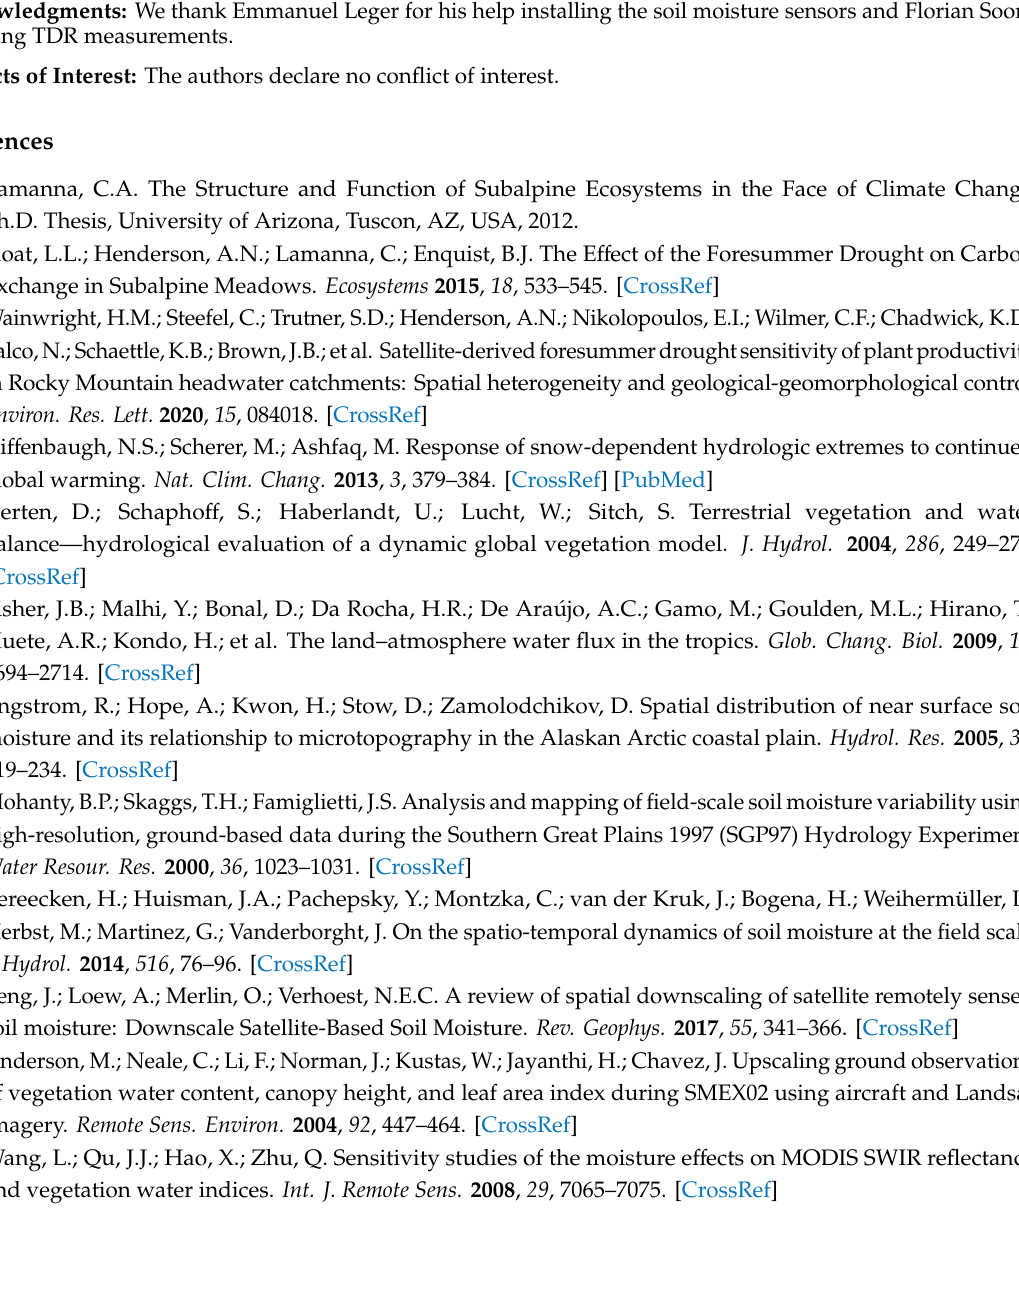
Table S4: Percent coverage of plant functional types from Falco et al. (2019) [15] for each